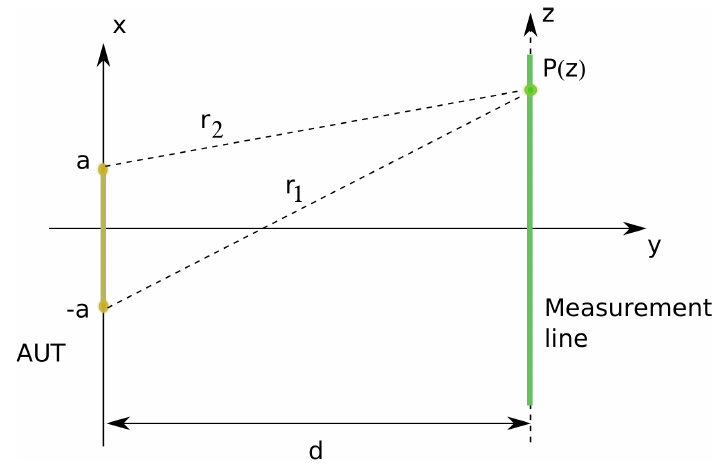
Figure 2. Relevant for the linear source example.